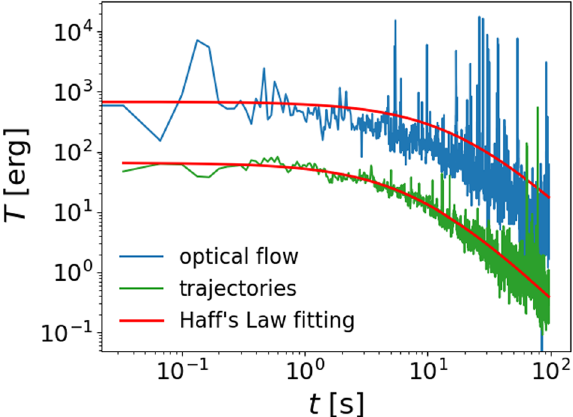
Fig. 5 Cooling dynamics. Cooling dynamics of translational motion of the particles. npj Microgravity (2022)